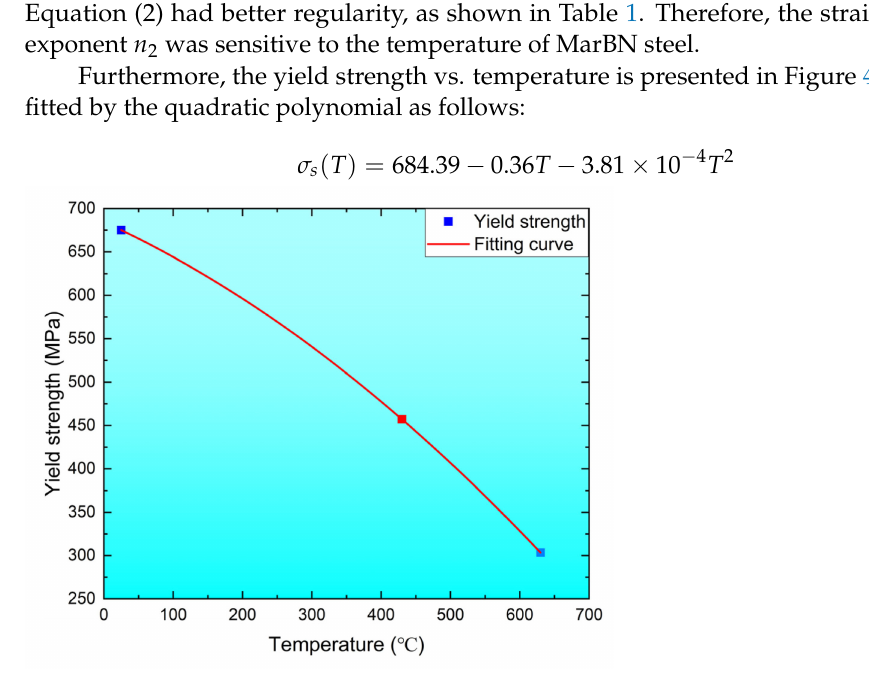
Figure 4. The fitted curve of the yield strength vs. the